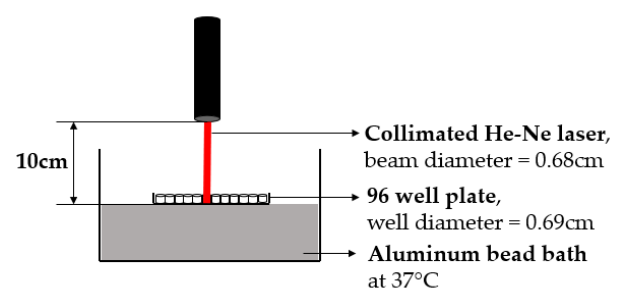
Figure 3. He-Ne Laser treatment experimental